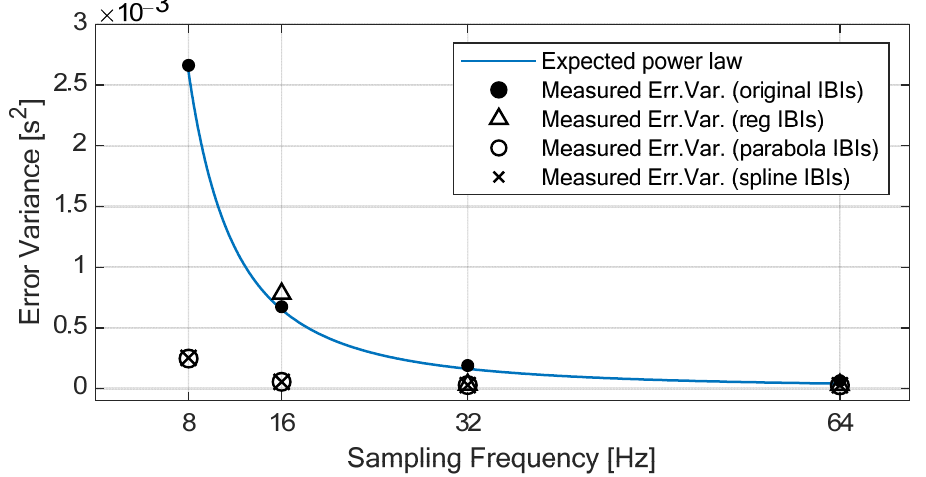
Figure 4. Comparison of the error variance measured on the IBIs with the theoretical one as a function of the sampling frequency. Without PPG interpolation (black points), the measured error variance resembles the expected power law. With interpolation (triangles, circles, and crosses), the error variance measured with the different methods almost overlaps from 64 to 32 Hz; at 16 Hz, an increase in error variance is observed with the REG method, whereas PARABOLA and SPLINE values remain overlapped. Table 5. Effect sizes (Cohen’s r ) of the investigated differences. ORIG: beat-to-beat AEs of the original IBIs; SPL and PAR: beat-to-beat AEs of the IBIs derived from PPG signals interpolated through SPLINE and PARABOLA approaches,